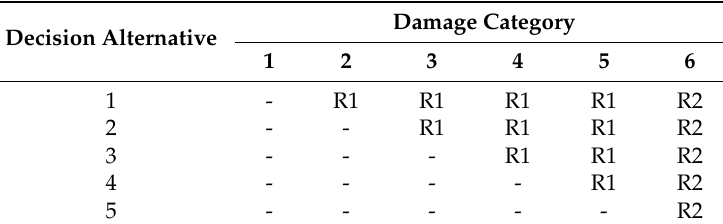
Table 1. Summary of decision